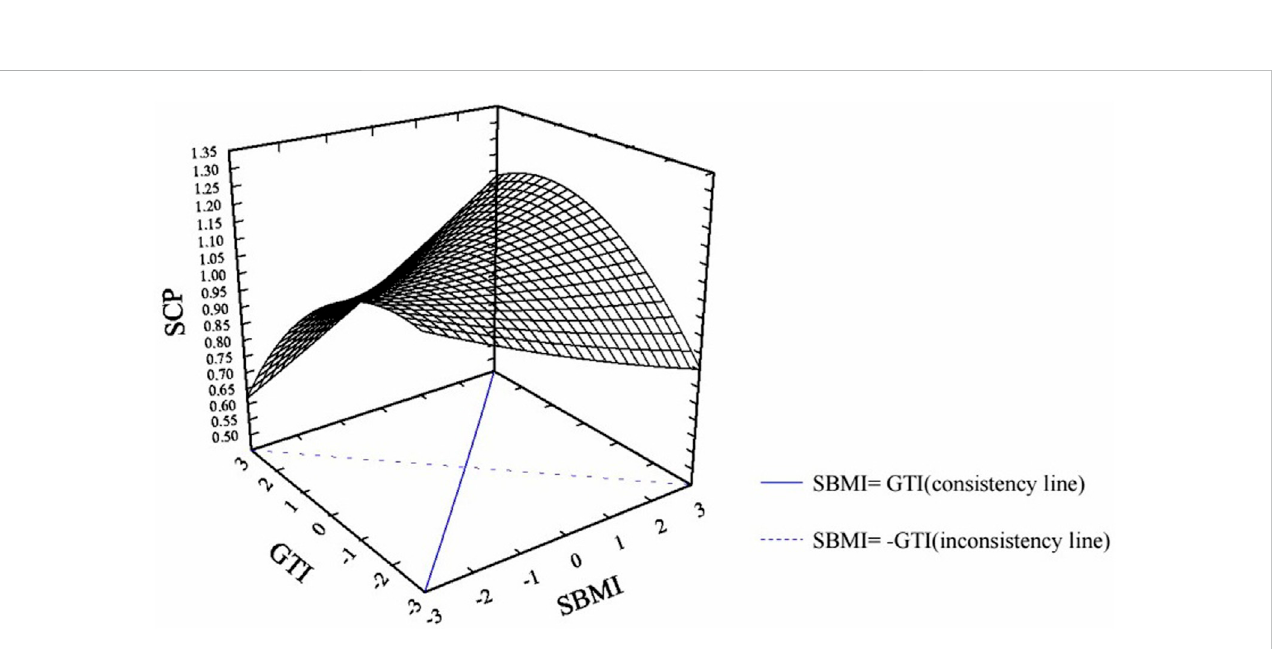
Frontiers in Environmental